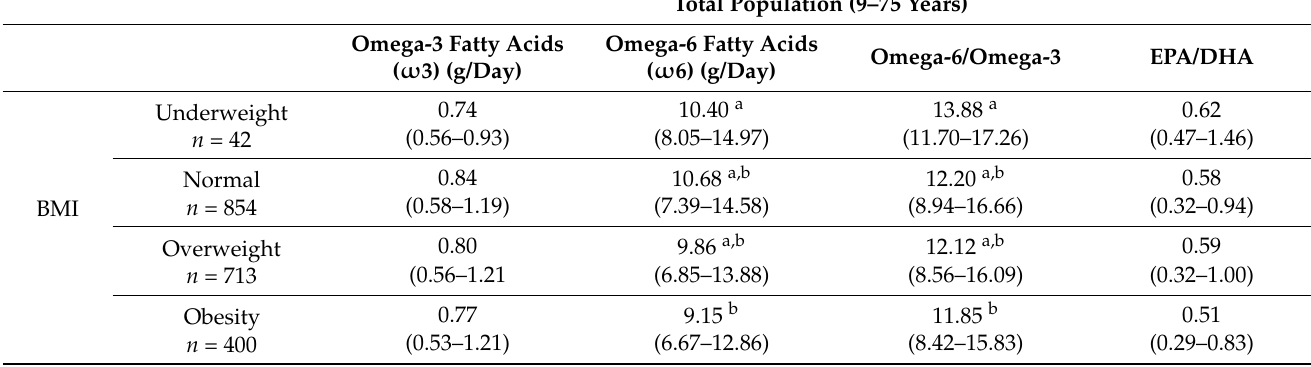
Table 7. Omega-3 and omega-6 fatty acid dietary intake and ratios according to body weight among the ANIBES Study population.